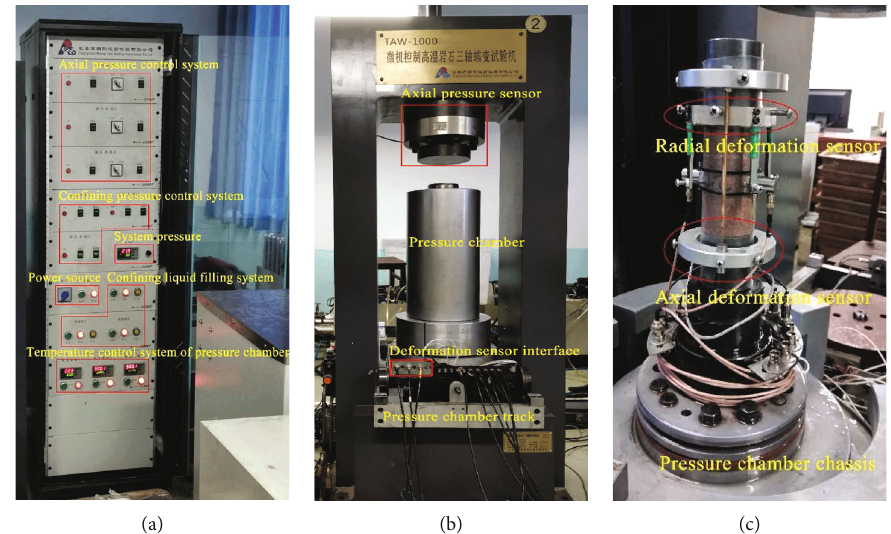
Figure 4: TAW-1000 rock triaxial creep testing machine: (a) electronic control system; (b) testing machine; (c) deformation measurement